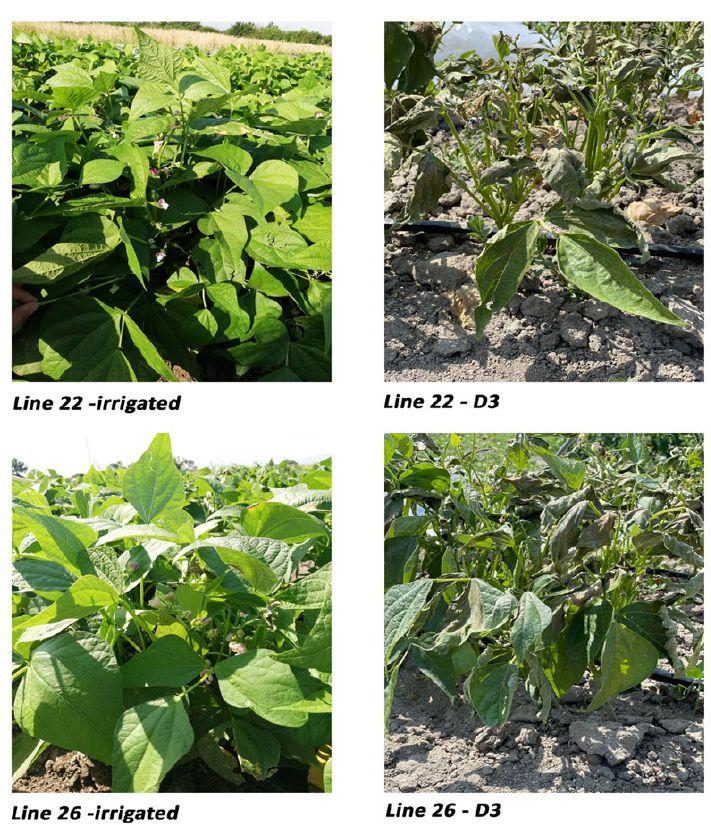
Figure 3. Visualization of common bean mutant lines 22 and 26 in irrigated state and after drought treatment (D3).